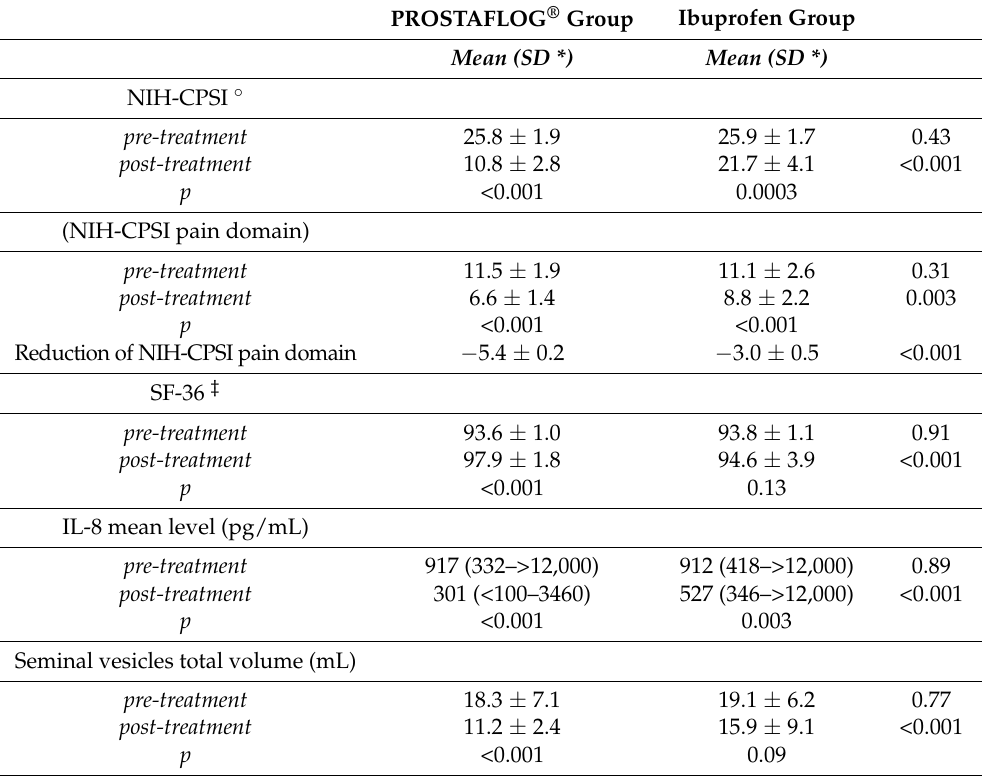
Table 2. The clinical and laboratory results at the follow-up